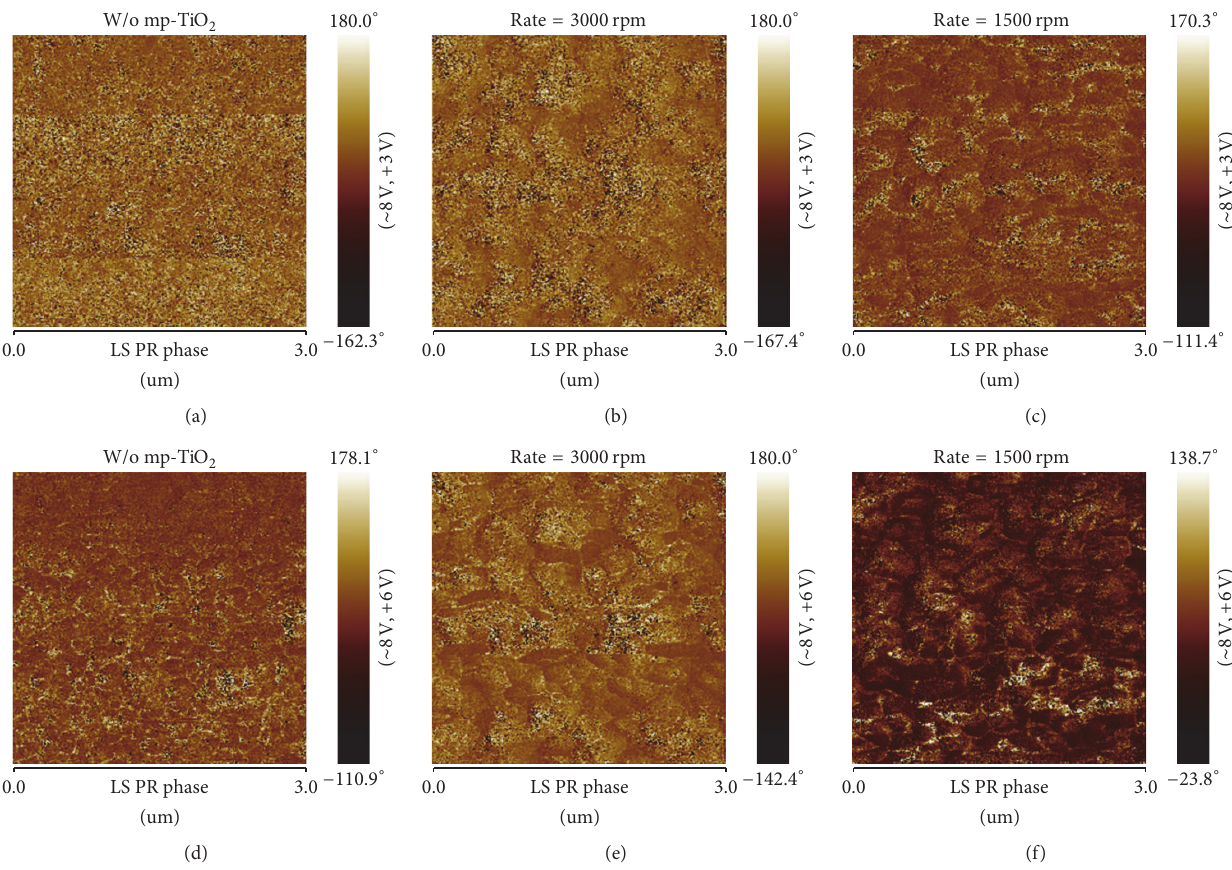
Figure 5: PFM phase images of the CH 3 NH 3 PbI 3 perovskite films which applied ( ∼ 8V, +3V) (a) w/o mp-TiO 2 layer and with the spin- coating rate of the mp-TiO 2 precursor for (b) 3000 rpm and (c) 1500 rpm. PFM phase images of the CH 3 NH 3 PbI 3 perovskite films which applied ( ∼ 8 V, +6V) (d–f) correspond to those which applied ( ∼ 8V, +3V) without mp-TiO 2 layer and with the different spin-coating rates of the mp-TiO 2